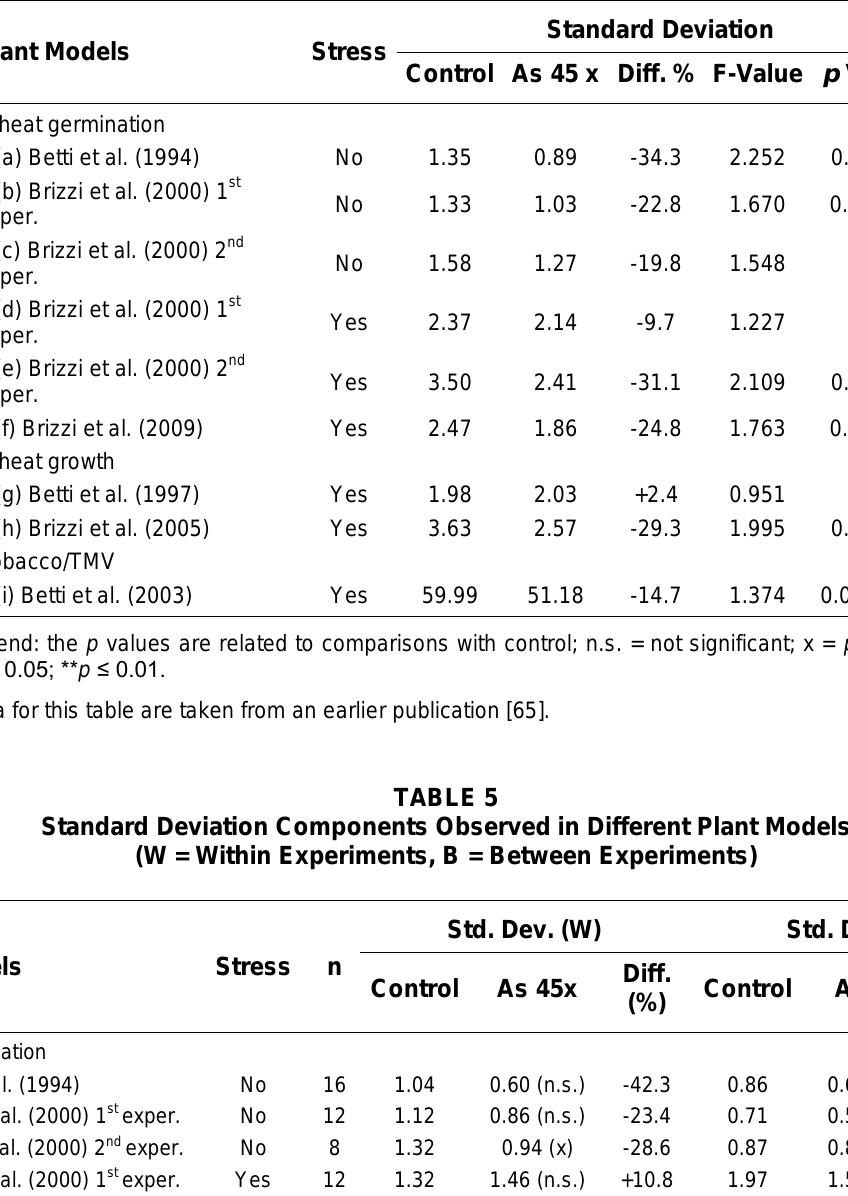
Global Standard Deviation Observed in Different Plant Models (Treatment vs. Control)